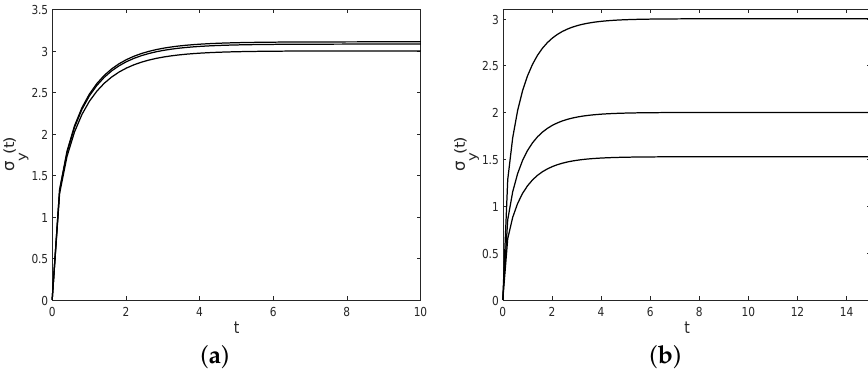
Figure 10. The coefficient of variation σ y ( t ) is plotted for r = 1 and ( a ): y = 0.1 and C = 1,2,3 (from bottom to top); ( b ): C = 1 and y = 0.1,0.2,0.3 (from top to bottom).